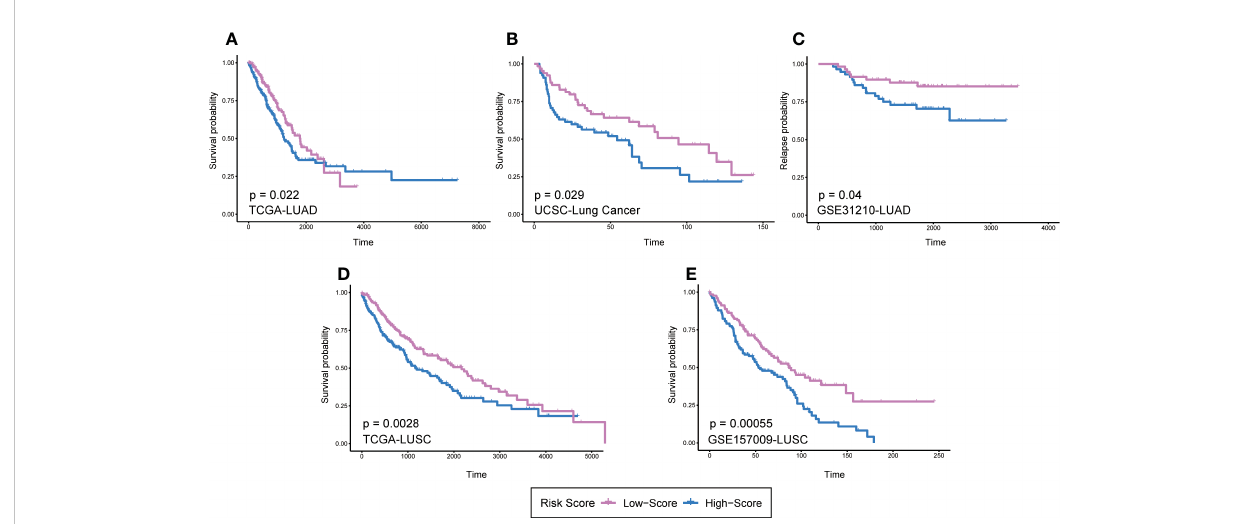
FIGURE 6 RS models of different pathological types based on 13 DRGs. (A) LUAD-RS model reconstruction in TCGA LUAD dataset. (B) LUAD-RS model validation in UCSC lung cancer dataset. (C) LUAD-RS model validation in GSE31210 dataset. (D) LUSC-RS model reconstruction in TCGA LUSC dataset. (E) LUSC-RS model validation in GSE157009 dataset. Patients were divided into high and low risk groups according to the median RS. DRGs, Differentiation Related Genes; RS, risk scores; TCGA, The Cancer Genome Atlas; USCS, University of California Santa Cruz; LUAD, lung adenocarcinoma; LUSC, lung squamous cell